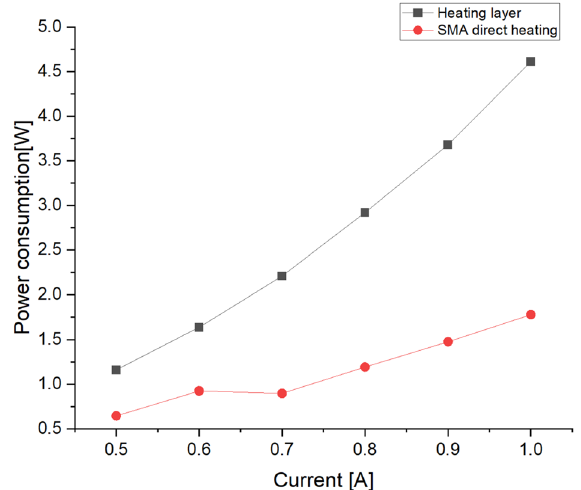
Fig. 7 Power consumption dependence on the current in heating layer and SMA